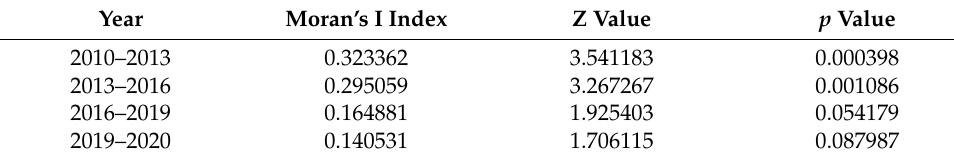
Figure 11. Spatial pattern evolution of the uncoordinated coupling degrees: ( a ) The uncoordinated coupling degrees in 2010; ( b ) The uncoordinated coupling degrees in 2013; ( c ) The uncoordinated coupling degrees in 2016; ( d ) The uncoordinated coupling degrees in 2019; ( e ) The uncoordinated coupling degrees in 2020. Table 4. Test results for the global Moran’s I index from 2010 to